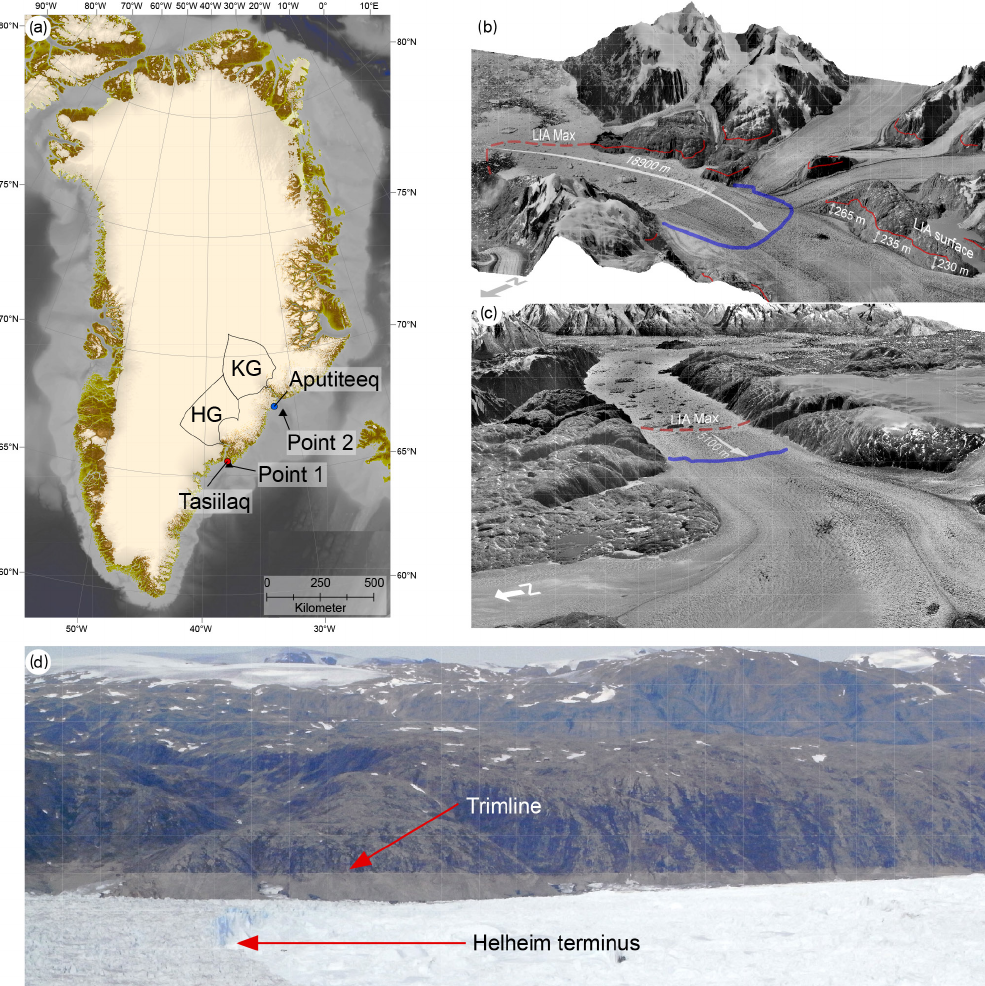
Figure 1. (a) Map of south Greenland and the location of Helheim Glacier (HG) and Kangerdlugssuaq Glacier (KG). The solid black lines denote the catchments of Helheim and Kangerdlugssuaq glaciers. The locations of meteorological stations at Tasiilaq and Aputiteeq operated by the Danish Meteorological Institute (DMI) are shown by red and blue circles, respectively. Black triangles represent points where we created the SST anomaly time series. (b) Orthophoto from 1981 of Kangerdlugssuaq Glacier draped onto the 1981 Digital Elevation Model (DEM). Red lines show the extent during the Little Ice Age (LIA) maximum and the blue lines shows the glacier front position in 2012. (c) Same as (b) but for Helheim Glacier. Note that due to glacier fluctuations during the 20th century Helheim Glacier was very close to its LIA maximum extent by 1981. (d) Photo of the Helheim terminus in August